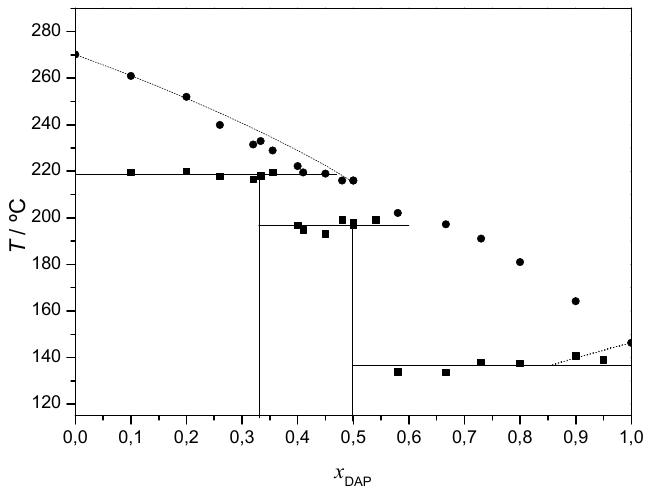
Figure 7. X-ray powder diffractograms of DAP + THEO mixtures, x DAP = 0.33, obtained by different experimental methodologies.